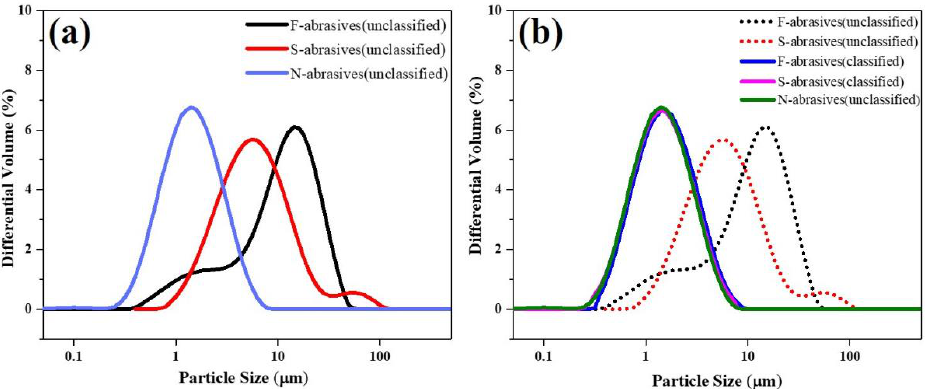
Figure 6. Particle size distributions of unclassified ( a ) and classified ( b ) ceria-based